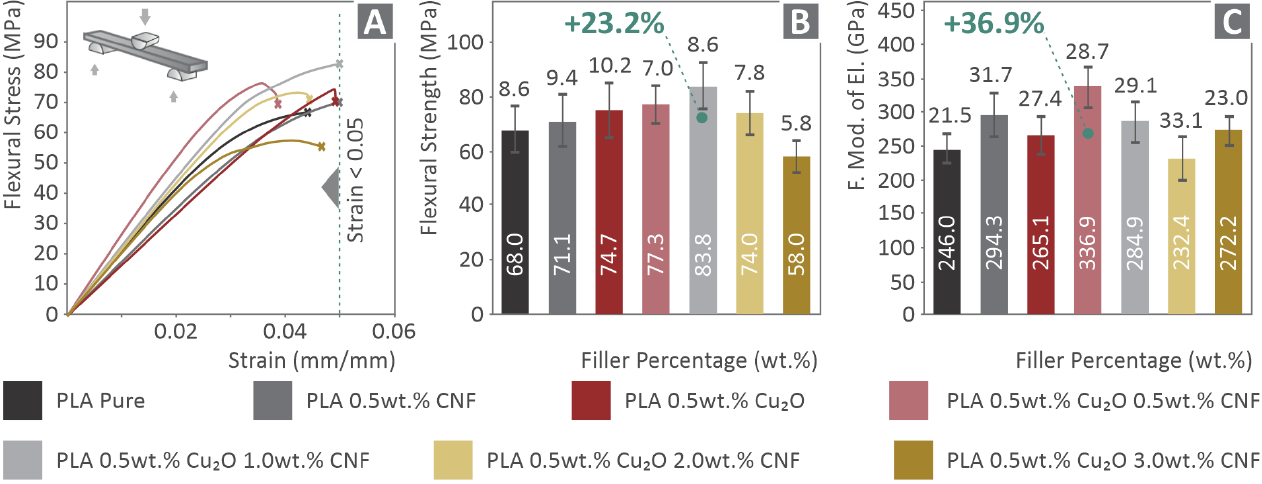
Figure 8. For all materials tested: ( A ) flexural stress vs. strain graph, ( B ) flexural strength and deviation (five specimens were tested), ( C ) flexural modulus of elasticity and deviation (five specimens were tested).